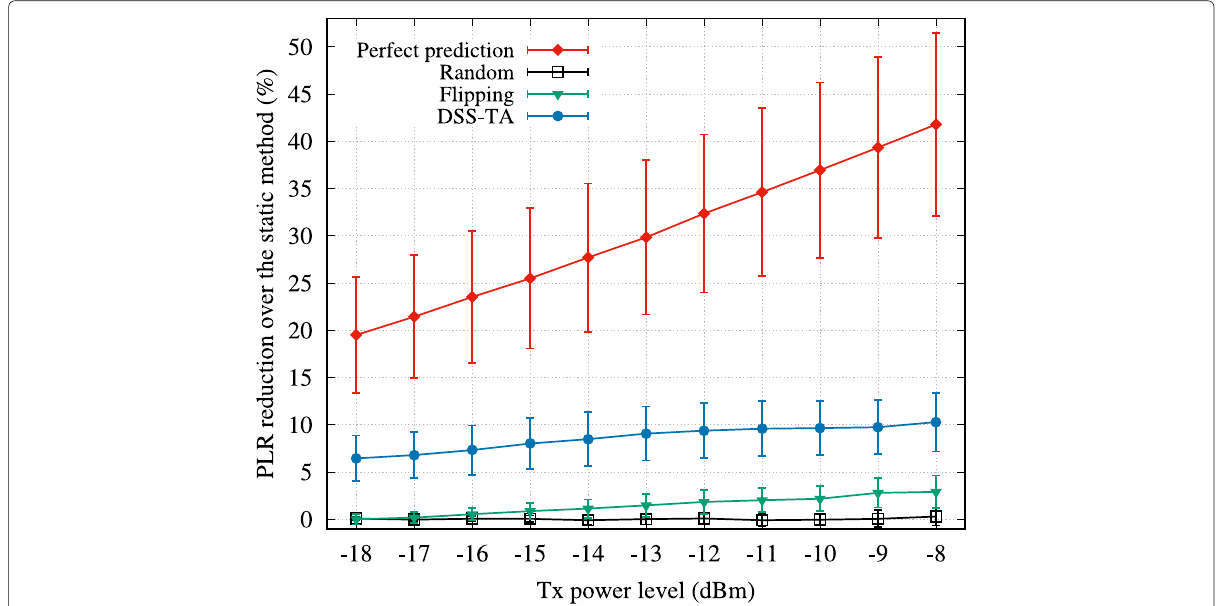
Fig. 13 PLR reduction over the static method vs. Tx power level, superframe length 70